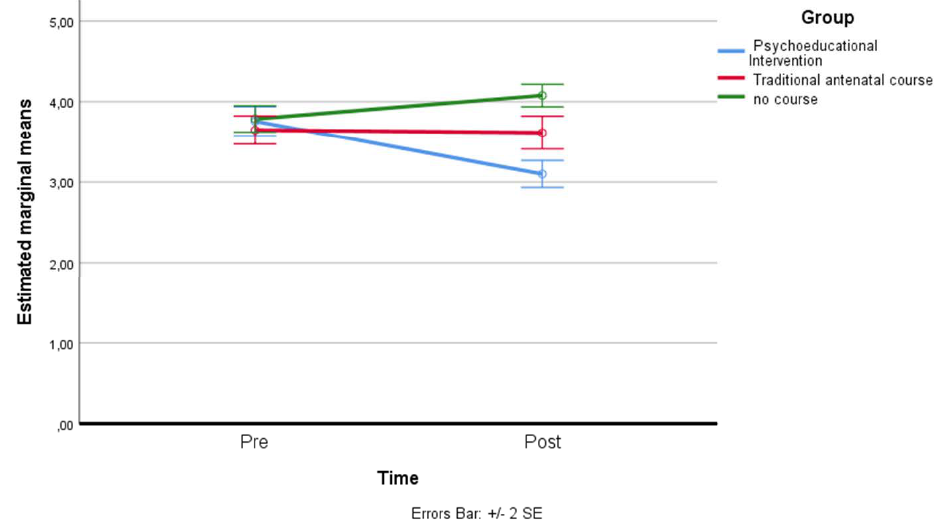
Figure 5. Estimated marginal means of perceived need for reassurance.